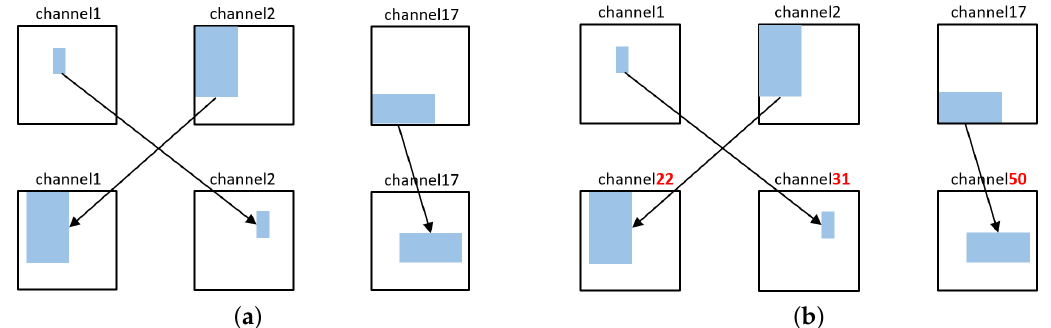
Figure 5. Sample illustration of the negative set generation. ( a ) Maintain category combination while changing each position; ( b ) change category combination with changing each position.